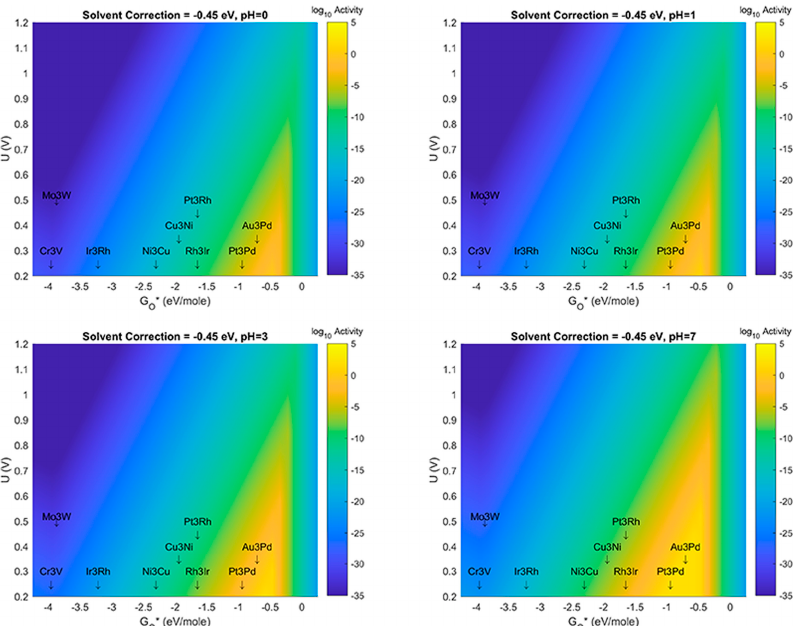
Figure 6. Volcano Plot analysis for Oxygen Reduction Reaction (ORR) activity at solvent correction value of –0.45 eV. Top left (pH = 0), Top right (pH = 1), Bottom left (pH = 3), Bottom Right (pH = 7). Blue denotes lowest activity, yellow denotes highest activity. All plots use same color-axis scale hence some saturation at maximum activity and minimum activity. Activity given in log10 scale to show more detail in plot (For Figures 6–9, zoomed in level plot details are given in the Supporting Information, Figures SI1 through SI4, respectively). Metals 2019 , 9 , x FOR PEER REVIEW